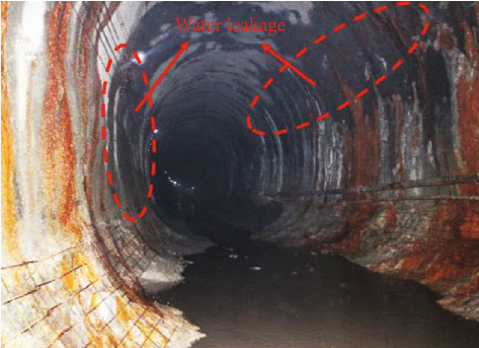
Figure 1: Water leakage in the subway